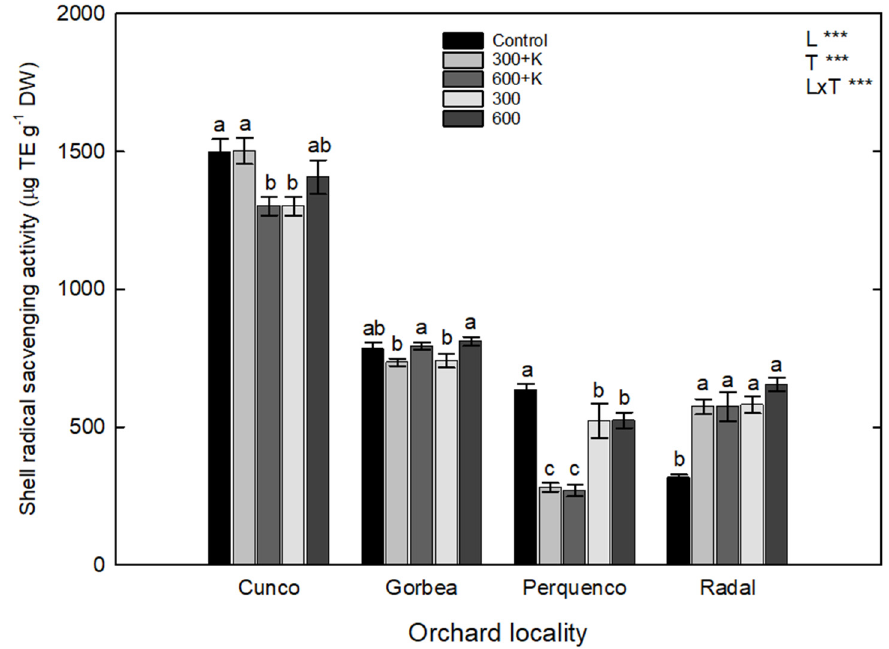
Figure 4. Radical scavenging activity (µg TE g − 1 DW) of the shells of TDG hazelnuts after the foliar spraying of Ca, Mg and K in four orchards in the La Araucanía region. Bars represent the average of four replicates ± S.E. Different letters indicate statistical differences ( p ≤ 0.05) between treatments in the same locality. Two-way ANOVA results are shown; *** p < 0.001. Control (water), 300+K (Ca+Mg+K at 300 mg L − 1 ), 600+K (Ca+Mg+K at 600 mg L − 1 ), 300 (Ca+Mg at 300 mg L − 1 ), and 600+K (Ca+Mg at 600 mg L − 1 ).